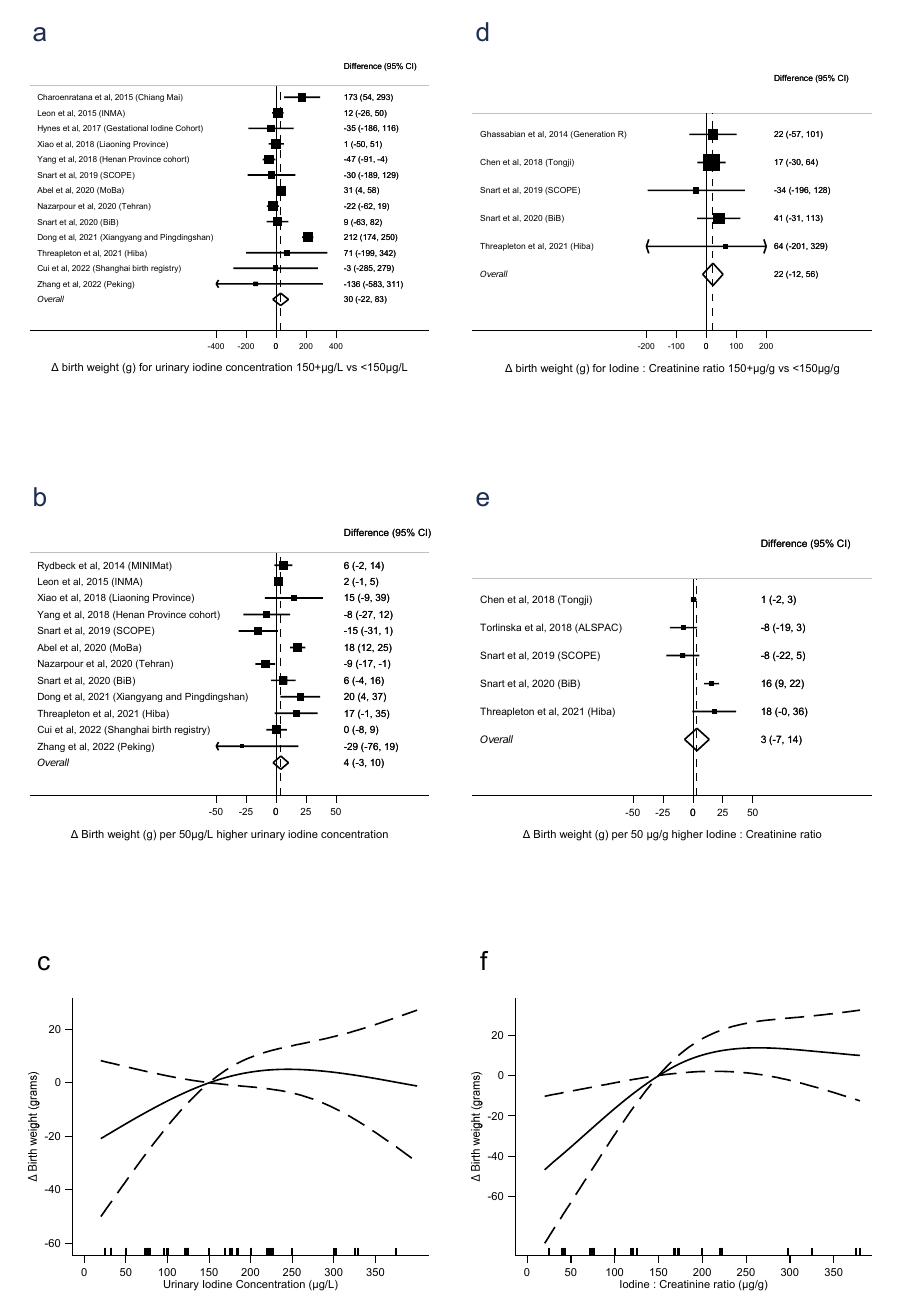
Figure 2. Urinary iodine concentration ( a – c ), iodine to creatinine ratio and birth weight (grams) ( d – f ), dichotomous ( a , d ), linear ( b , e ), and nonlinear ( c , f ) meta-analyses. CI: Confidence interval; ∆ : Change in outcome [11–14,16,28,29,31,33,34,36,37,39–42,44] Six studies reported birth weight in relation to I:Cr. There was no evidence that I:Cr ≥ 150 μ g/g was associated with greater birth weight than <150 μ g/g (difference = 22 g, − 12 to 56, p = 0.2, n = 5, I 2 = 0%), nor linear trend (3 g per 50 μ g/g, − 7 to 14, p = 0.5, n = 5, I 2 =